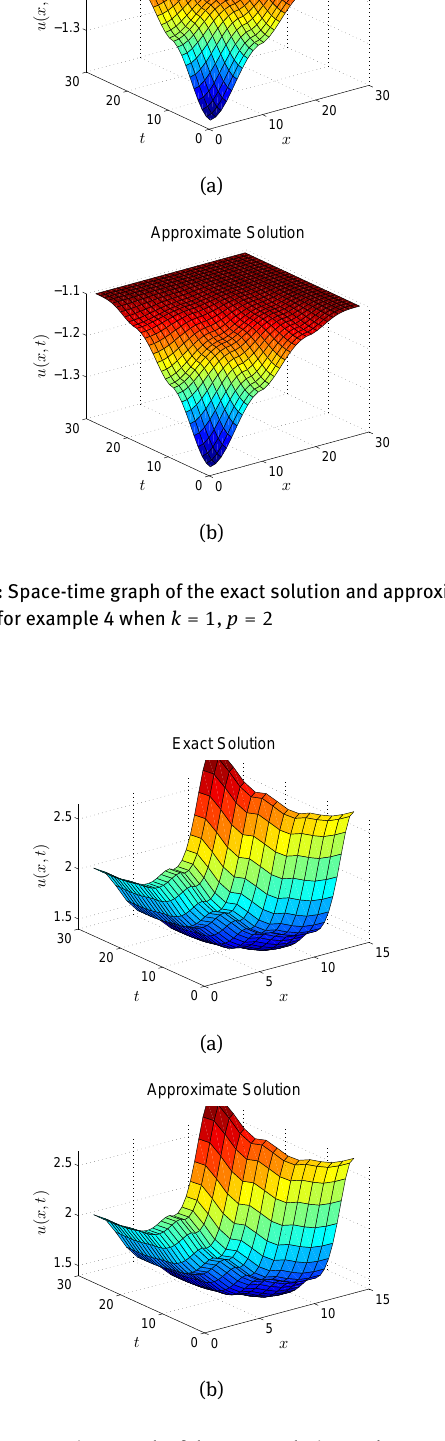
Figure 12: Space-time graph of the exact solution and approximate solution for example 5